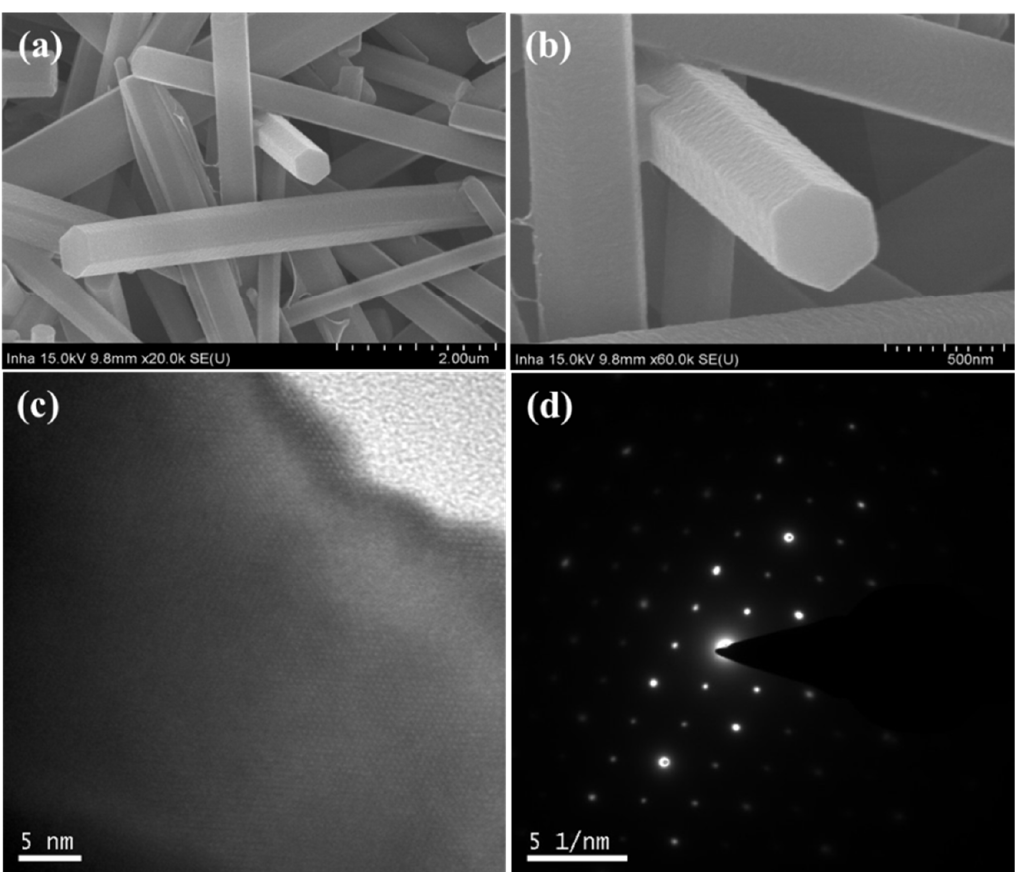
Figure 1. ( a , b ) show SEM images of the pristine Alq 3 MRs with different magnifications; ( c ) HR-TEM image of the single crystalline Alq 3 MR. ( d ) Corresponding SAED pattern of ( c ).